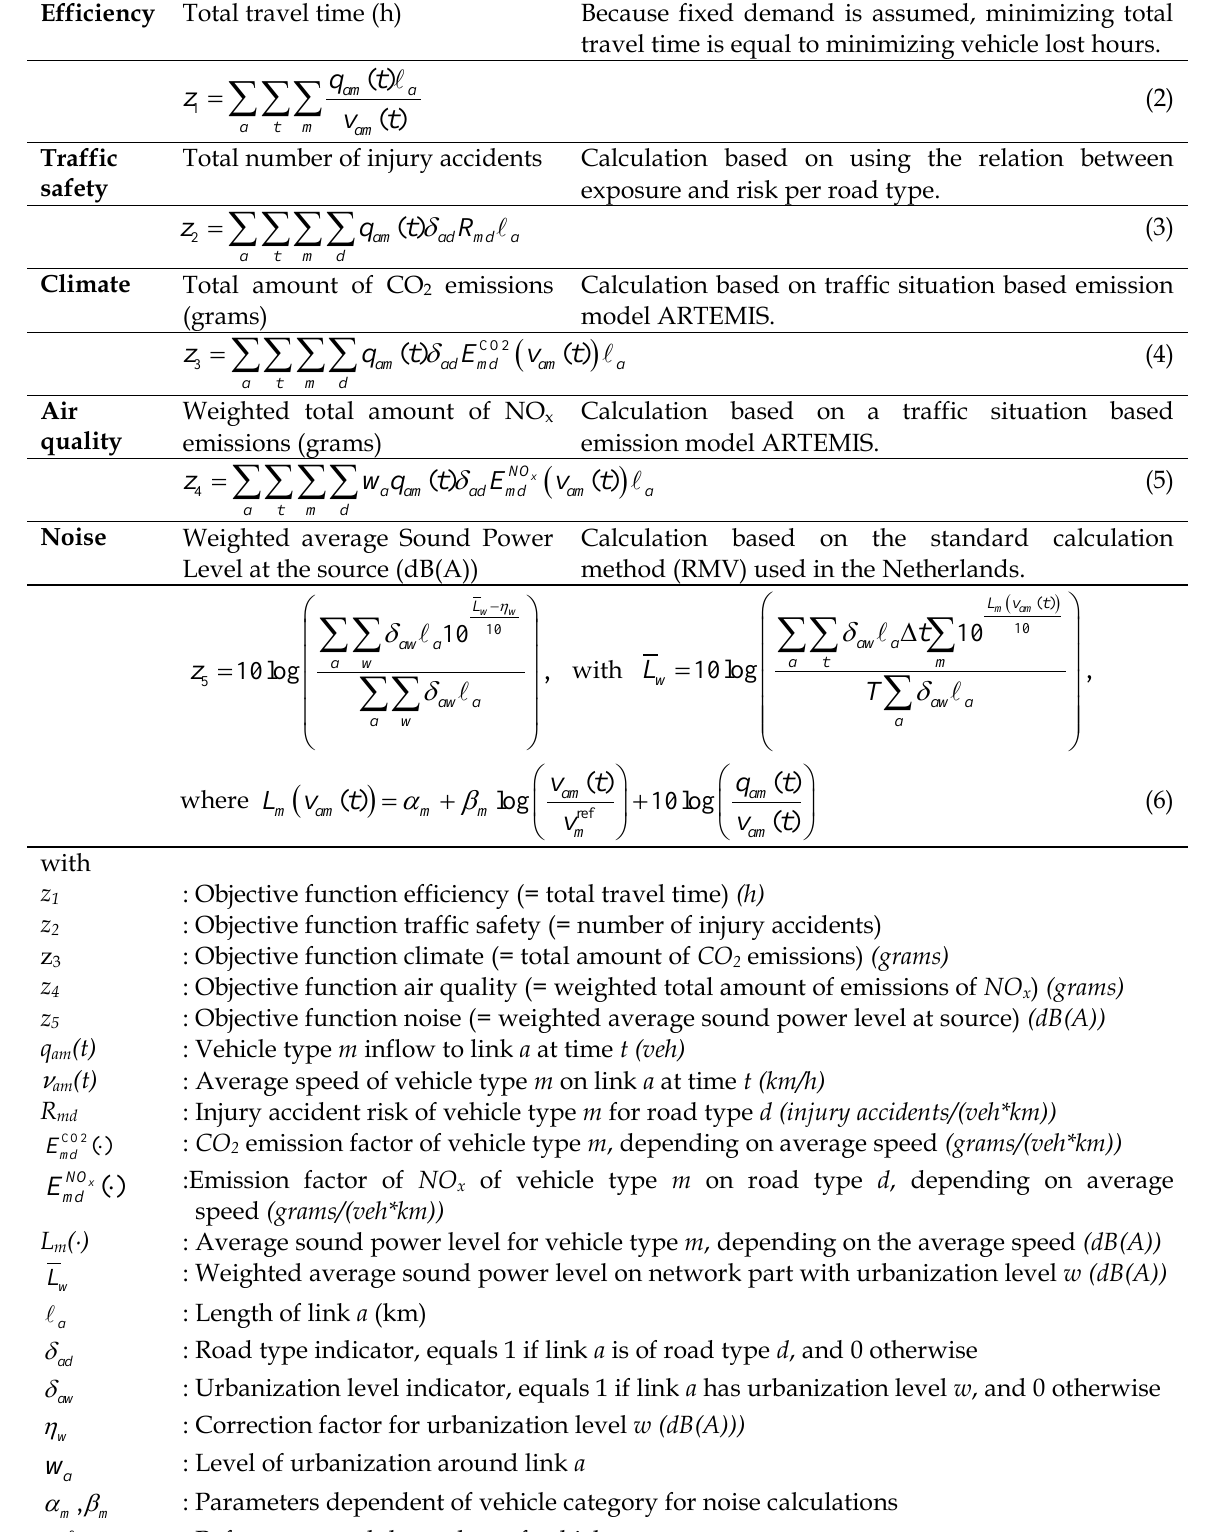
Table 1. Overview of measures and objective functions used